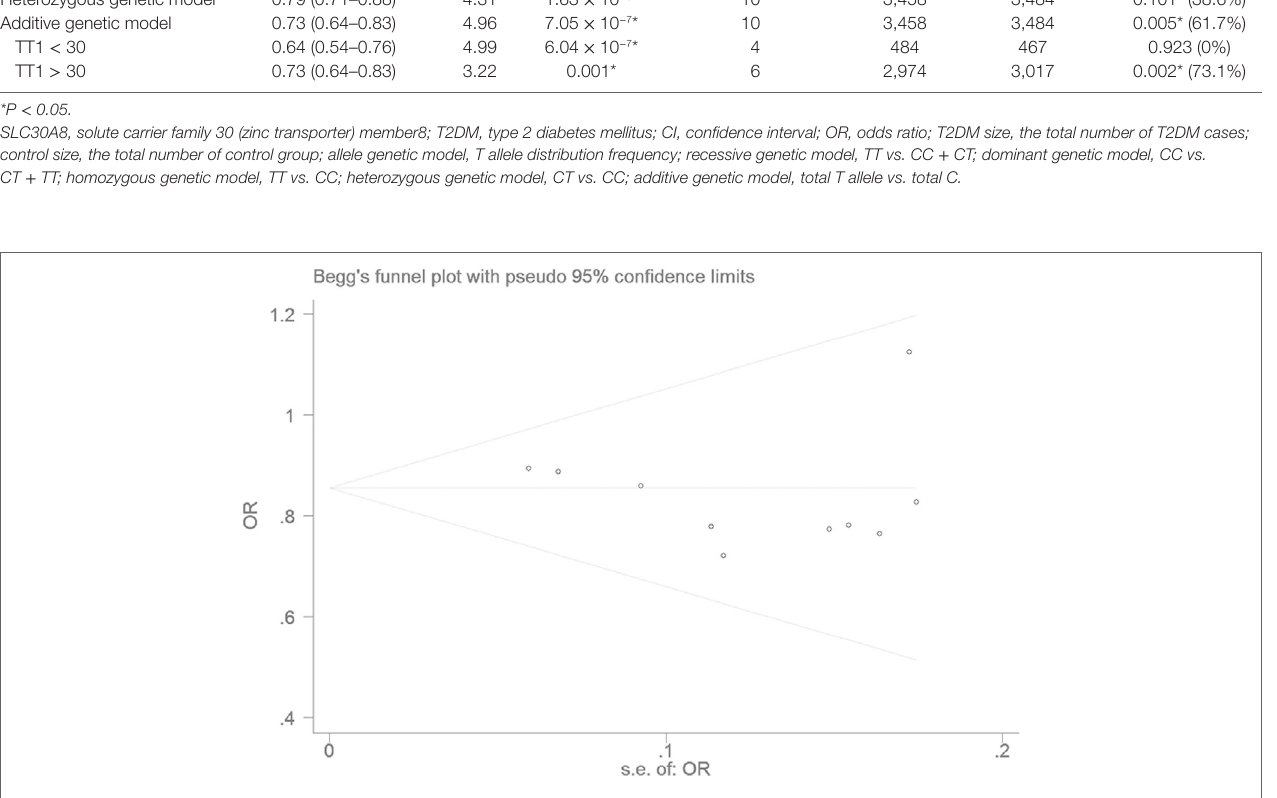
FiGURe 7 | Begger’s funnel plot for studies of type 2 diabetes mellitus associated with SLC30A8 gene rs13266634C/T in the Chinese population under a recessive genetic model (TT vs. CT + CC). The horizontal and vertical axis correspond to the OR and confidence limits. Abbreviation: OR, odds